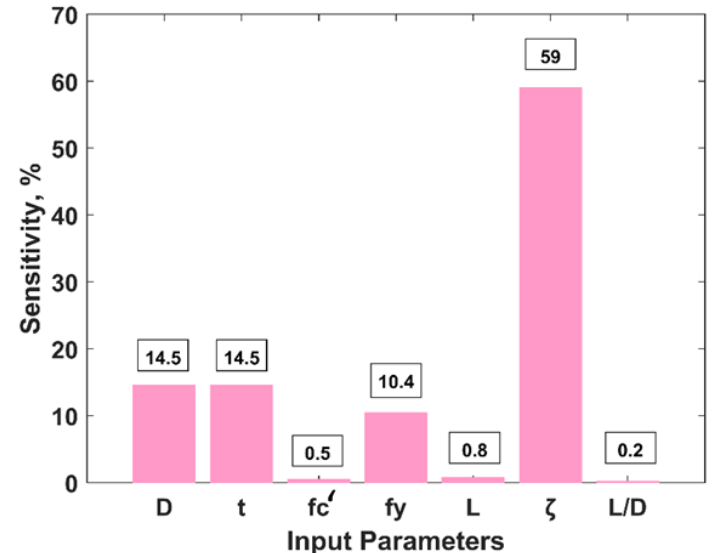
Figure 10. Sensitivity analysis of input variables.